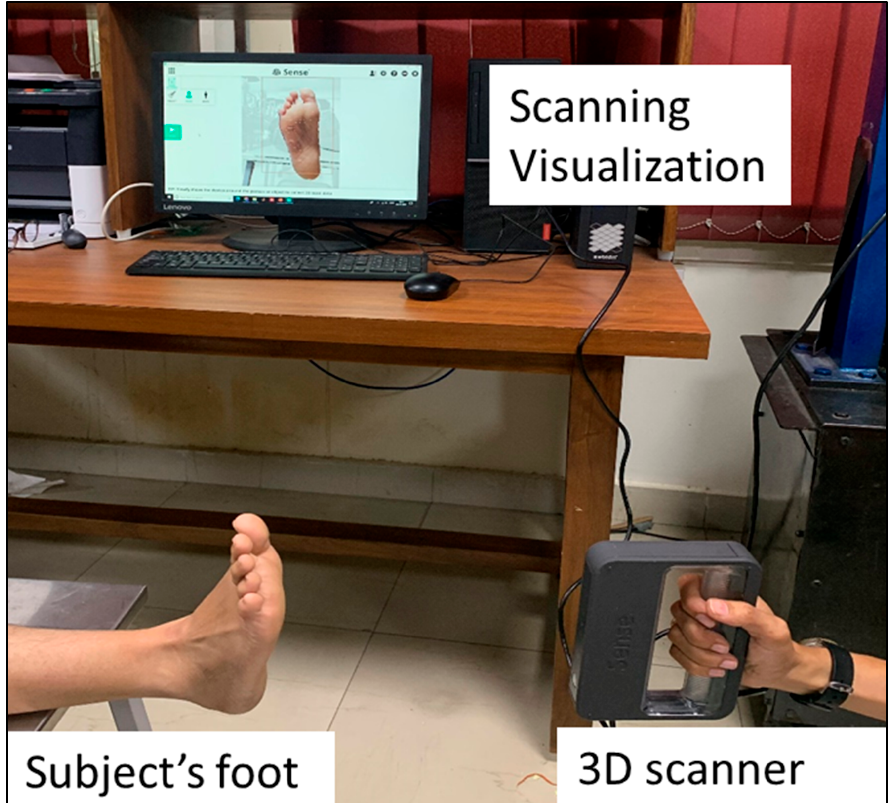
Figure 2. 3D scanning of the subject.